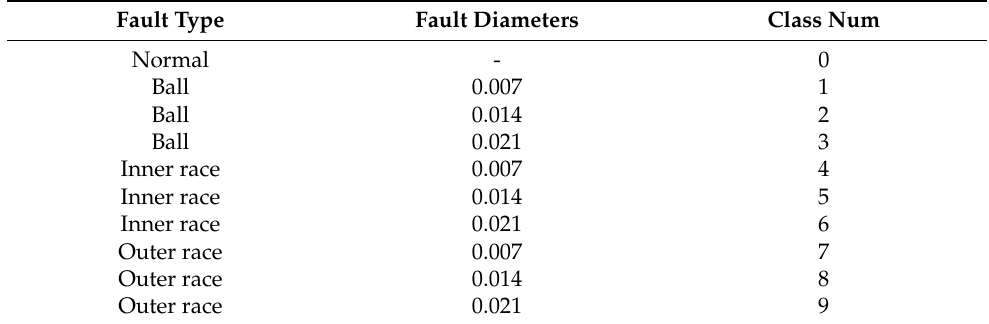
Table 4. Description of CWRU data.